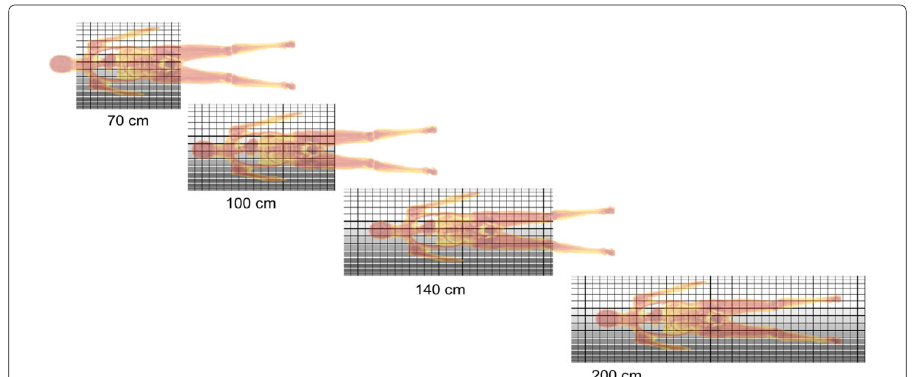
Fig. 8 Total body PET systems with an axial length of 70 cm, 100 cm, 140 cm and 200